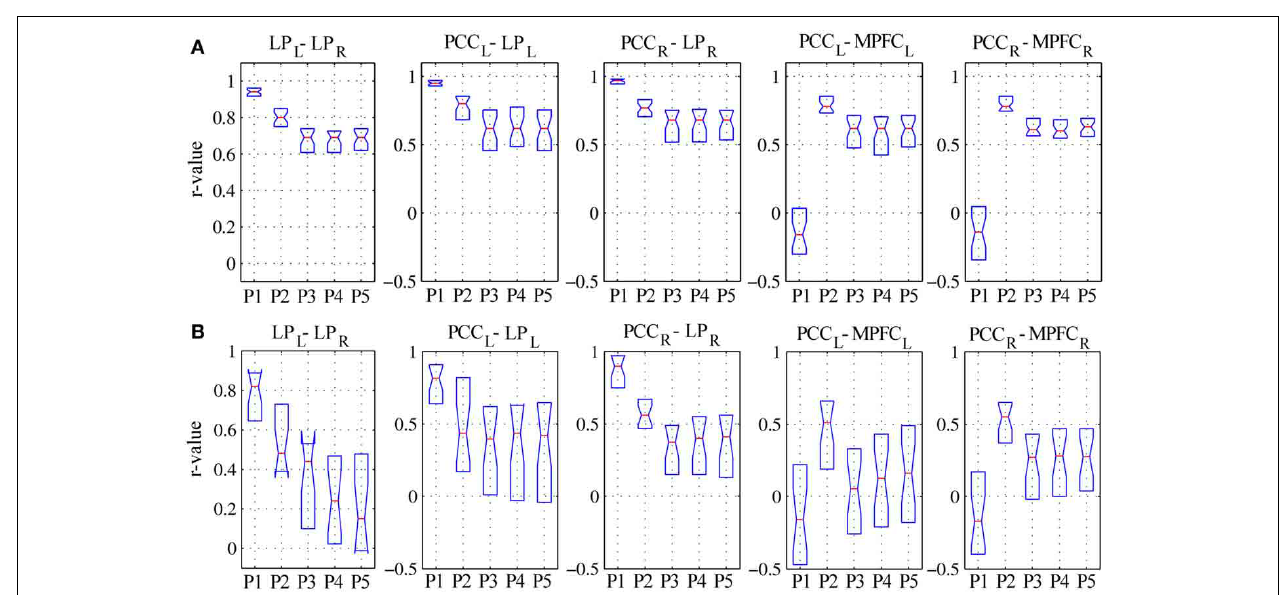
FIGURE 5 | Linear correlation coefficients for regionally-averagedBOLD signal time-series between DMN regions for (A) healthy controls and (B) patients. See text for description of the